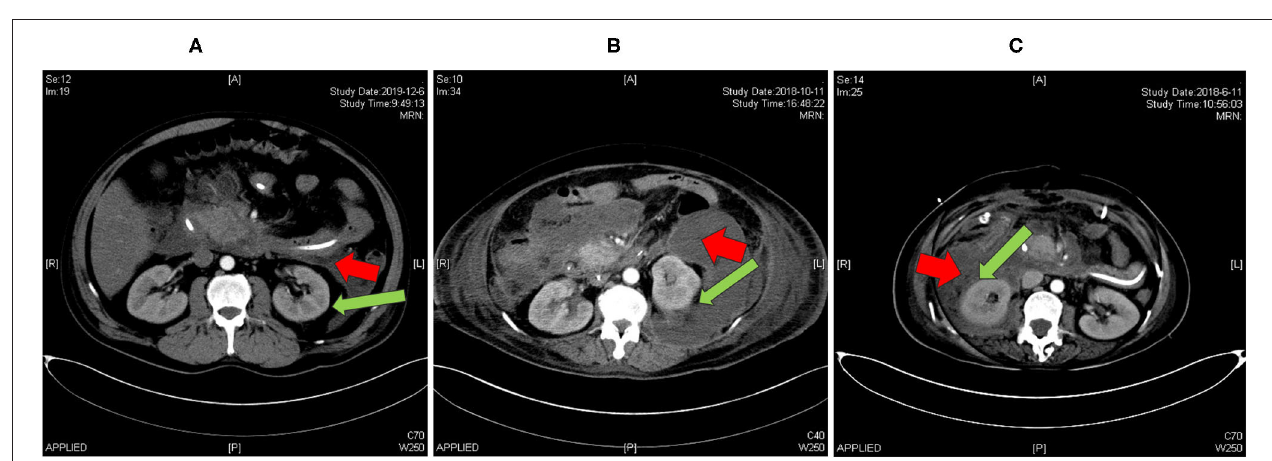
FIGURE 2 | Abdominal CT imaging (arterial phase) of patients with AP included in our study. (A) A patient admitted to hospital in December 2019 with no involvement of renal capsule (RRG II); (B) a patient admitted to hospital in October 2018 with partial involvement of renal capsule (RRG III); (C) a patient admitted to hospital in June 2018 with full involvement of renal capsule (RRG III). Red arrow: pancreatic collections, green arrow: renal capsule. RRG, renal rim grade.